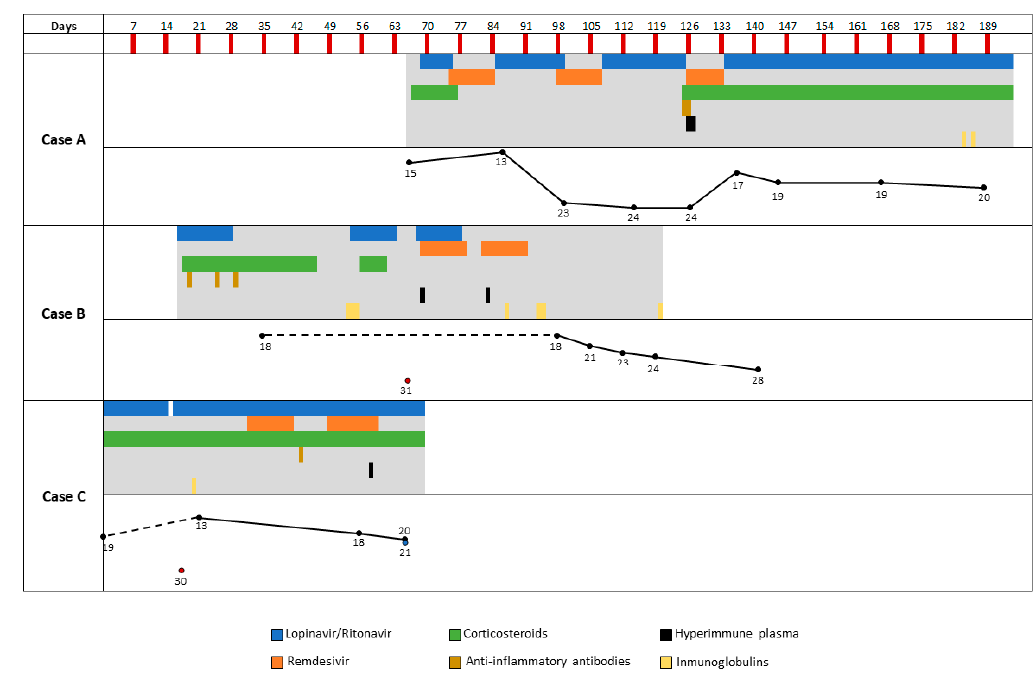
Figure 1. Treatment history for the study cases. Day 0 corresponds to diagnosis. For Case A, only the therapies administered during the period he was managed in our institution are indicated. Anti-inflammatory antibodies refer to either tozilizumab or anakinra. The graphs at the lower part of each case ´ s panel represent the Ct values for the positive RT-PCRs along the